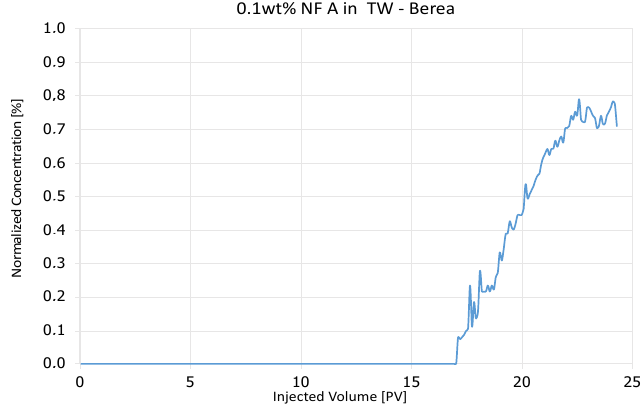
Figure 24. Preceding tracer test showing a nanofluid breakthrough after 17 PV. In this core flood, 0.1 wt% NF A in TW was injected and nanoparticle concentration was evaluated using DLS.